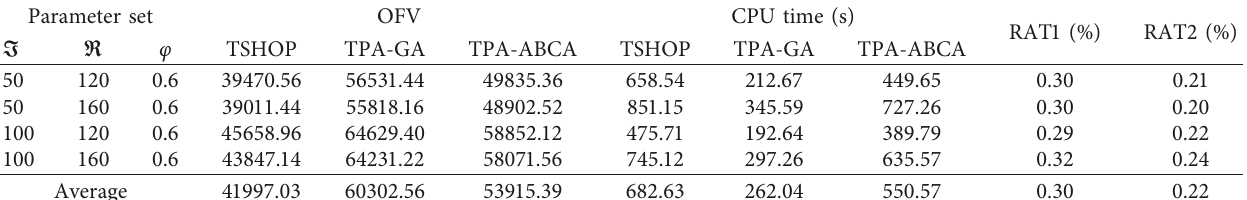
Table 9: Performance for TSHOP, TPA-GA, and TPA-ABCA applied to the instance with 34 item tasks. Parameter set